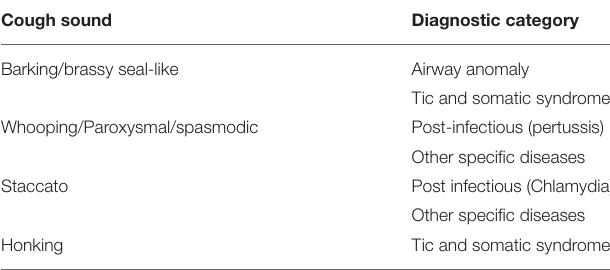
TABLE 5 | Cough sound and potential diagnostic category.